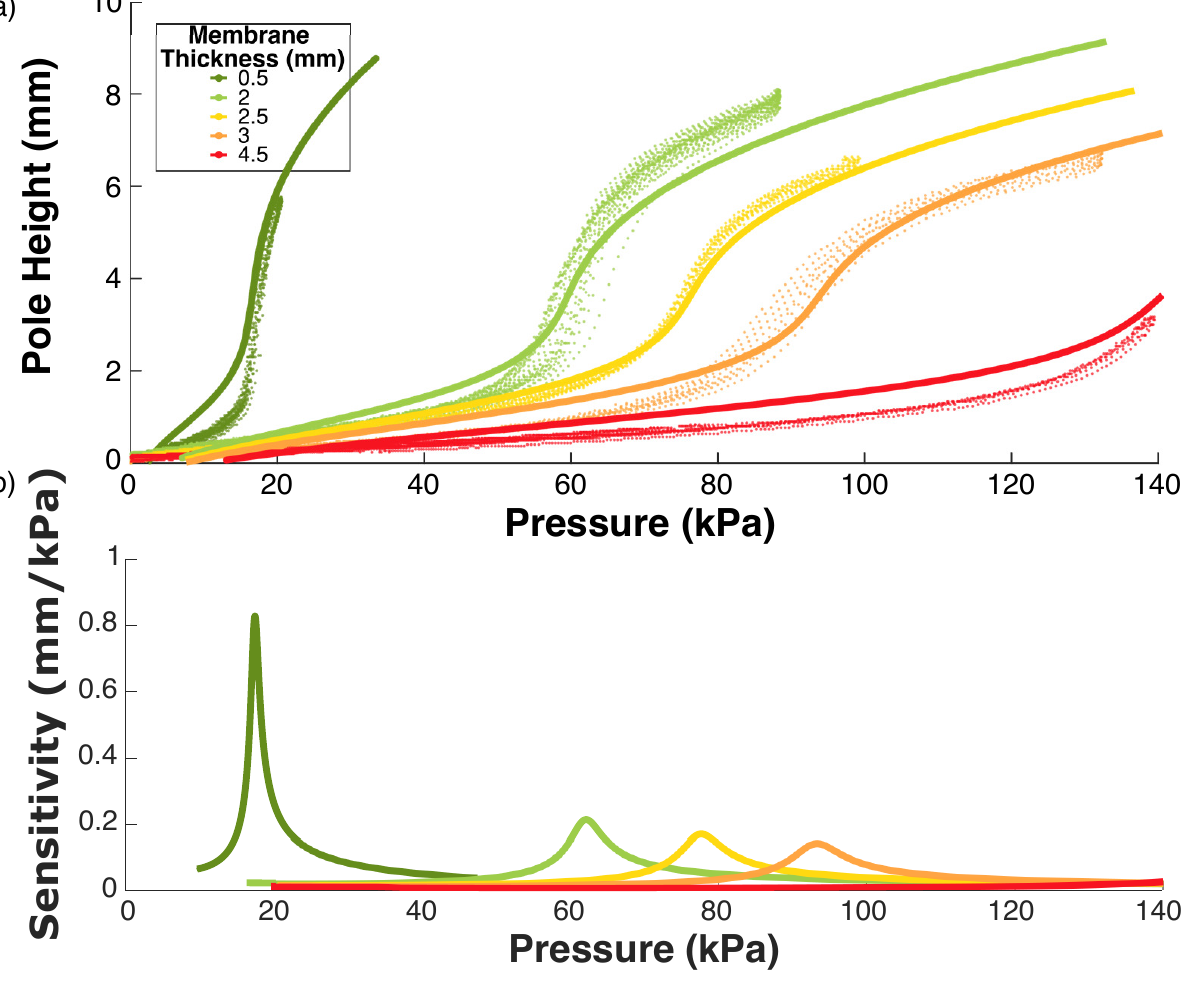
Figure 6. ( a ) Experimental data (markers) and modelled curves (solid lines) with Ogden parameters µ 1 = 911, α 1 = 5.88, µ 2 = 37,500, α 1 = 1.45 [46]. ( b ) Examination of the sensitivity of the membranes for each thickness tested. The membrane has the largest volume change in reaction to an applied force during the steepest stage of the